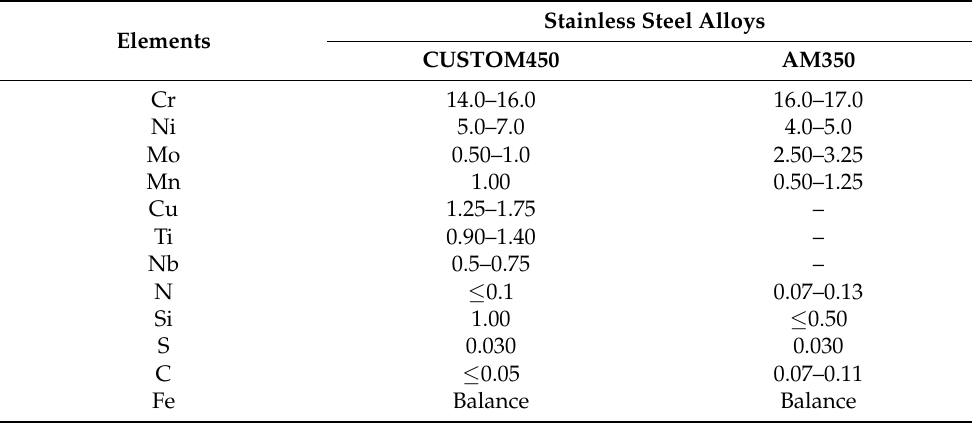
Table 1. Chemical composition of the CUSTOM450 and AM350 SS (wt.